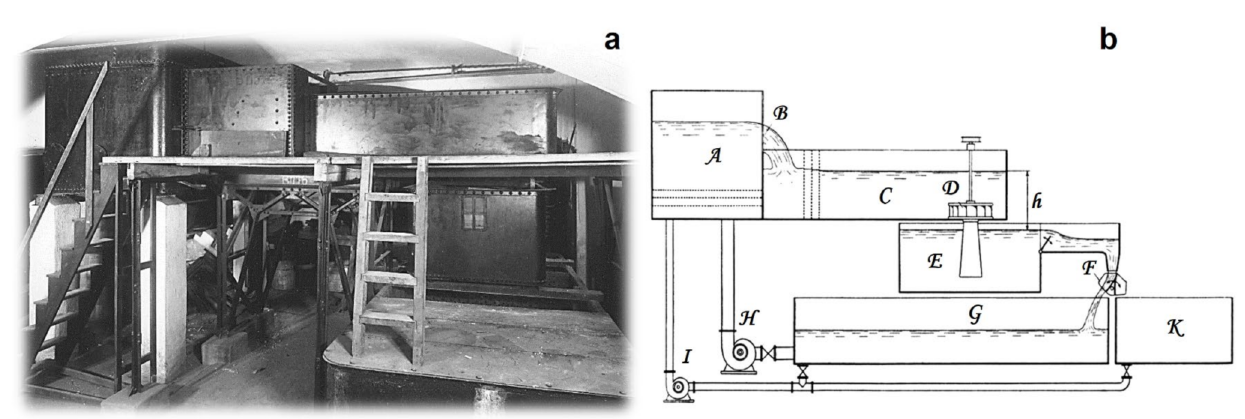
Figure 4. ( a ) Photo of turbine laboratory; ( b ) Scheme of the laboratory testing circuit. A: storage tank; B: measuring weir; C: turbine pit; D: experimental turbine; E: lower tank; F: tilting valve; G: reservoir; H: feed pump; I: auxiliary pump; K: calibration tank. Sources: ( a ) [6]; ( b )